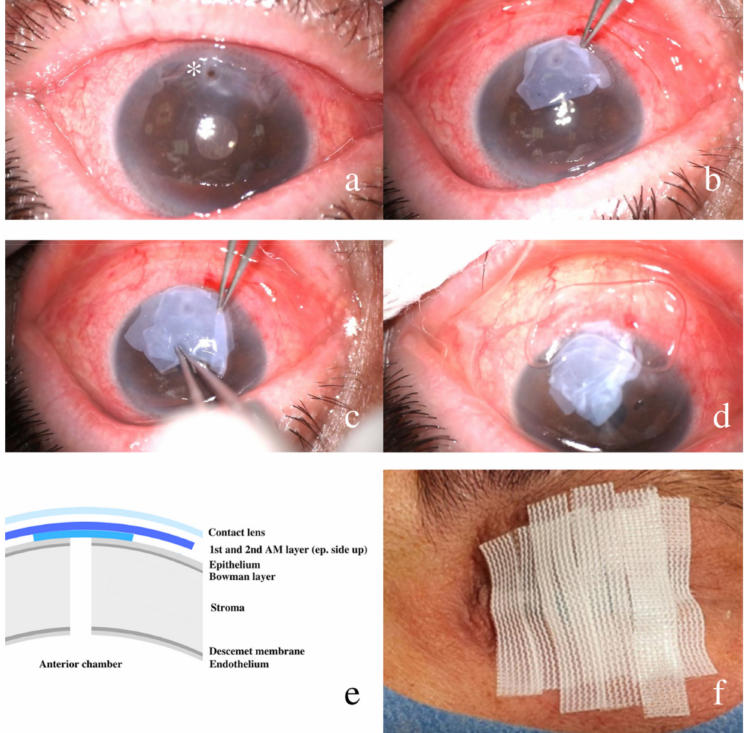
Figure 1. Corneal perforation (*) ( a ). First layer of amniotic membrane (AM) covering the corneal perforation ( b ). Second layer of AM placed on top of the first AM layer ( c ). Contact lens (12 mm diameter) placed above the 2 AM layers ( d ). Schematic representation of result of the surgical technique showing the 2 layers of AM covering the corneal perforation. The contact lens is shown on top of them ( e ). 3M™ Steri-strip™ R-100 × 12 mm used to close the eyelids ( f